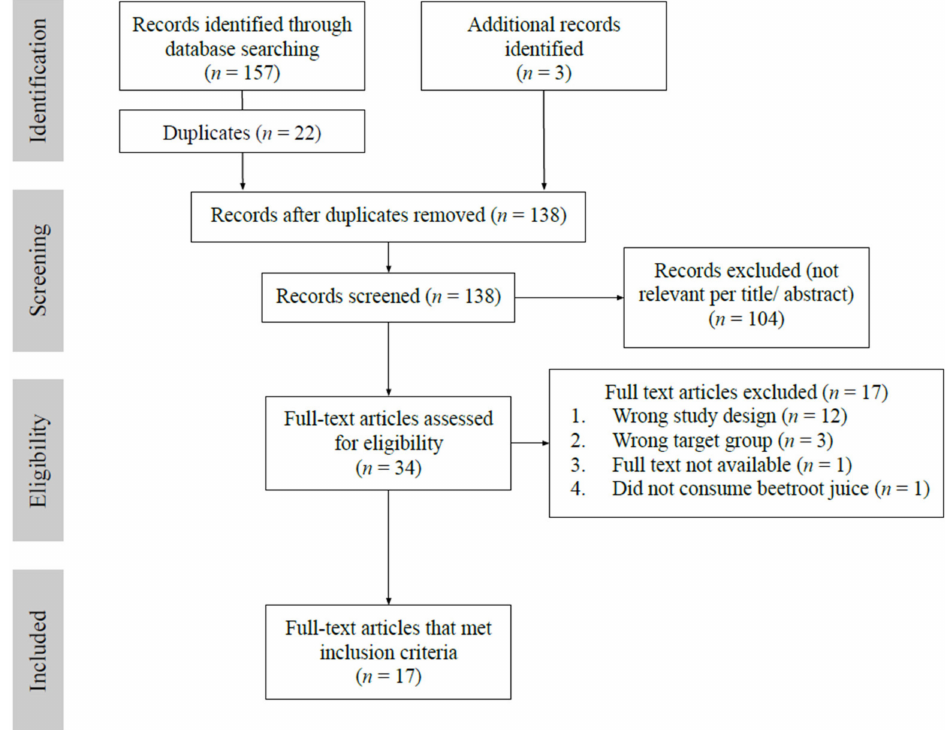
Figure 1. Selection process based on the Preferred Reporting Items for Systematic Reviews and Meta-Analysis (PRISMA)